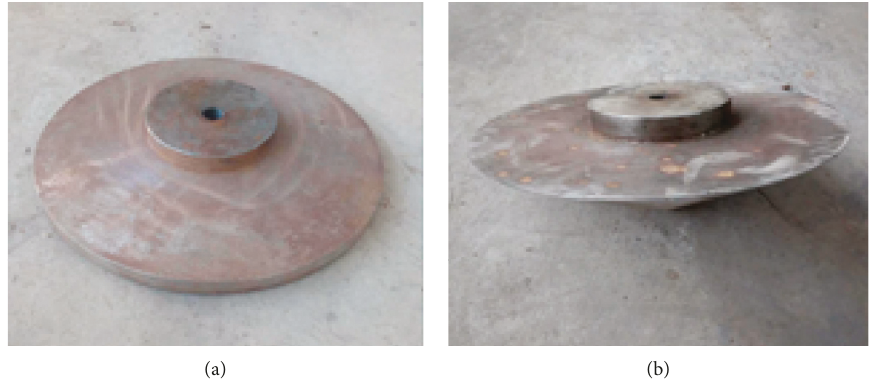
Figure 2: Scale foundation model. (a) Circular foundation. (b) Cone-shaped